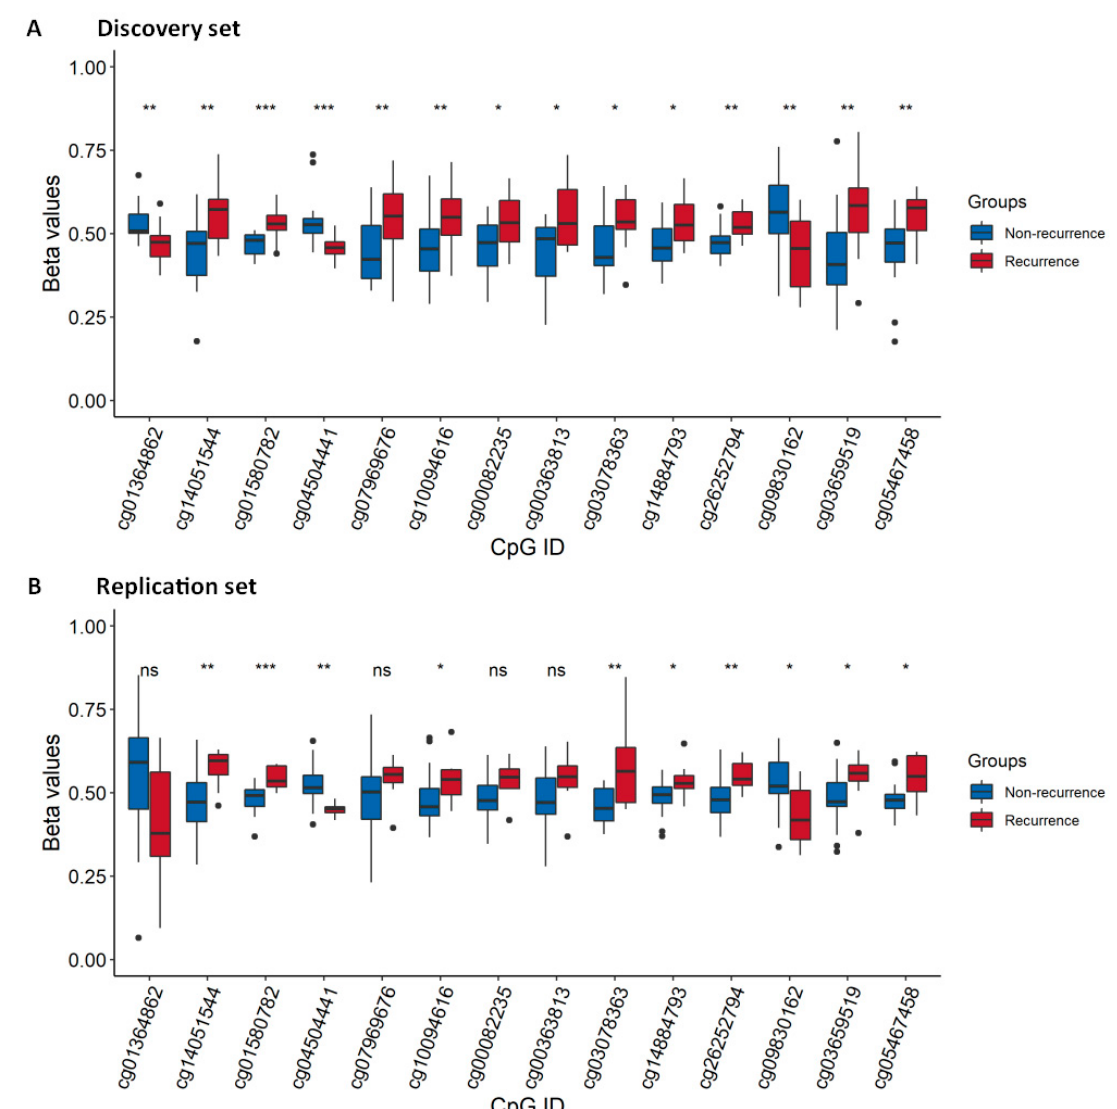
Figure 5. Box-plots comparing the β -values of the identified 14-CpG marker panel between recurrent and non-recurrent groups. ( A ) Discovery and ( B ) replication sets stratified by recurrence status. Middle line in each box represents the median; lower and upper box show the first and third quartiles, respectively. Whiskers represent the 95% confidence interval of the median. *** p < 0.001; ** p < 0.01; * p < 0.05; ns: not significant.